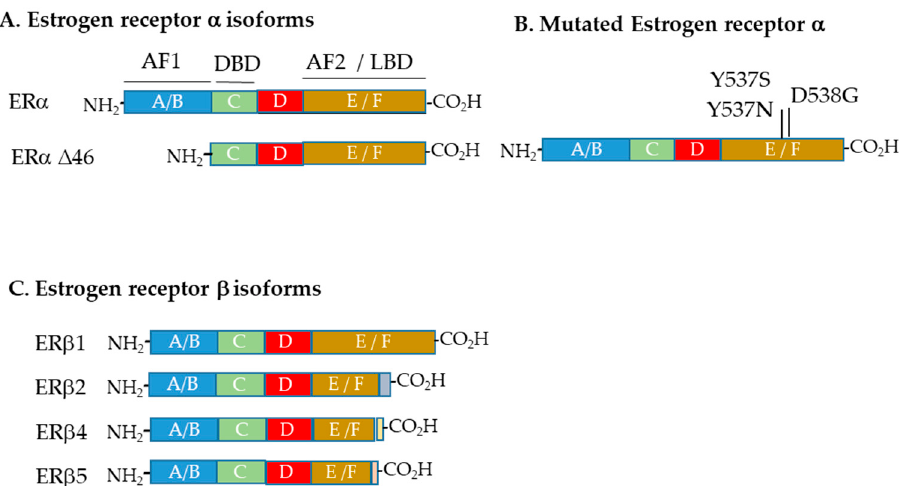
Figure 1. Estrogen receptor isoforms and mutants found within ovarian cancers. ( A ) Estrogen receptor alpha isoforms identified in ovarian cancers. ( B ) Mutated versions of estrogen receptor alpha found in ovarian cancers. Mutations at positions 537 and 538 have been observed. ( C ) Estrogen receptor beta isoforms identified in ovarian cancers. AF1 = Activation function 1; DBD = DNA binding domain; AF2 = Activation function 2; LBD = Ligand binding domain.